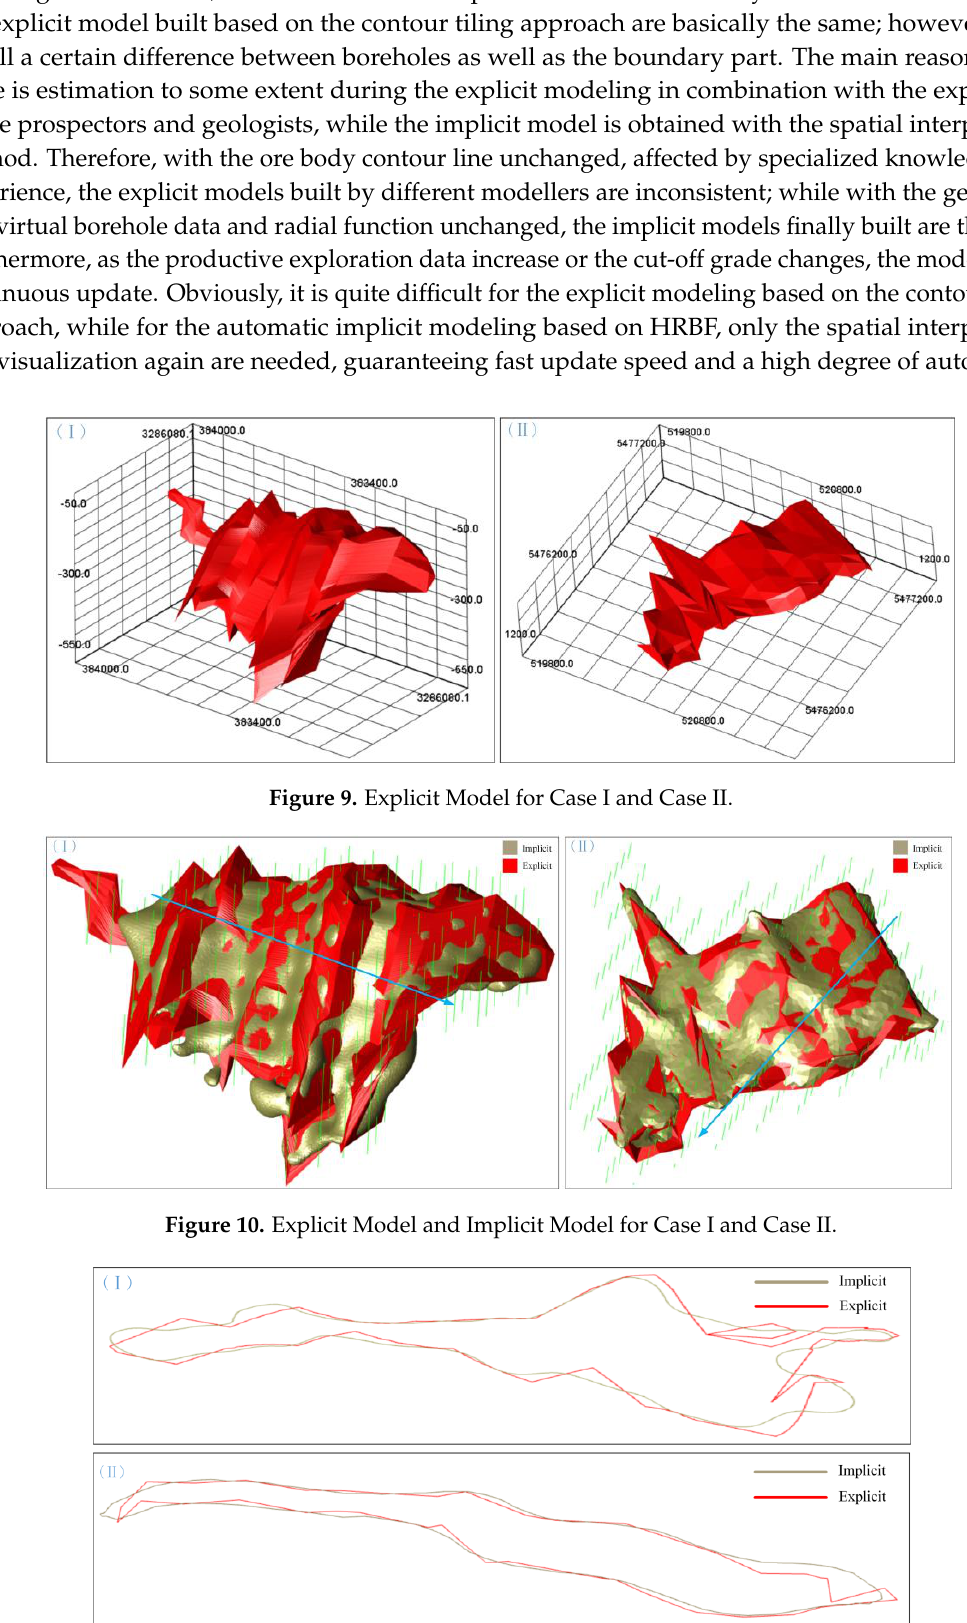
Figure 11. Sectioning Contour Line for Case I and Case II in the Blue Arrow Direction in Figure 10.